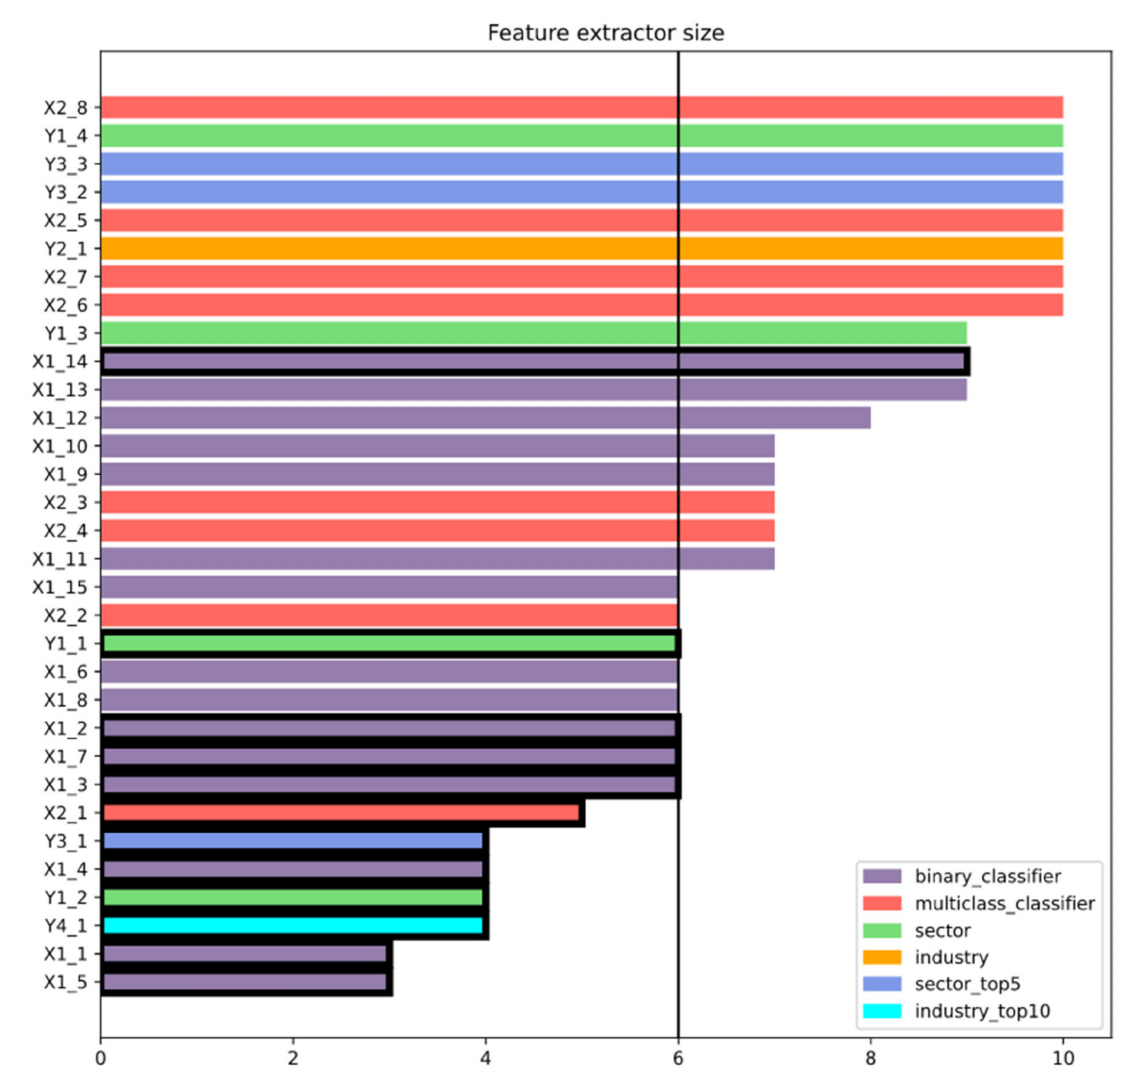
Figure 8. Feature extractor size (sum of convolution layers and max pooling layers) bar plot separated by model types based on their classification task. The black line indicates the mode of feature extractor size. Models with bolded box plot edges were selected for further cluster